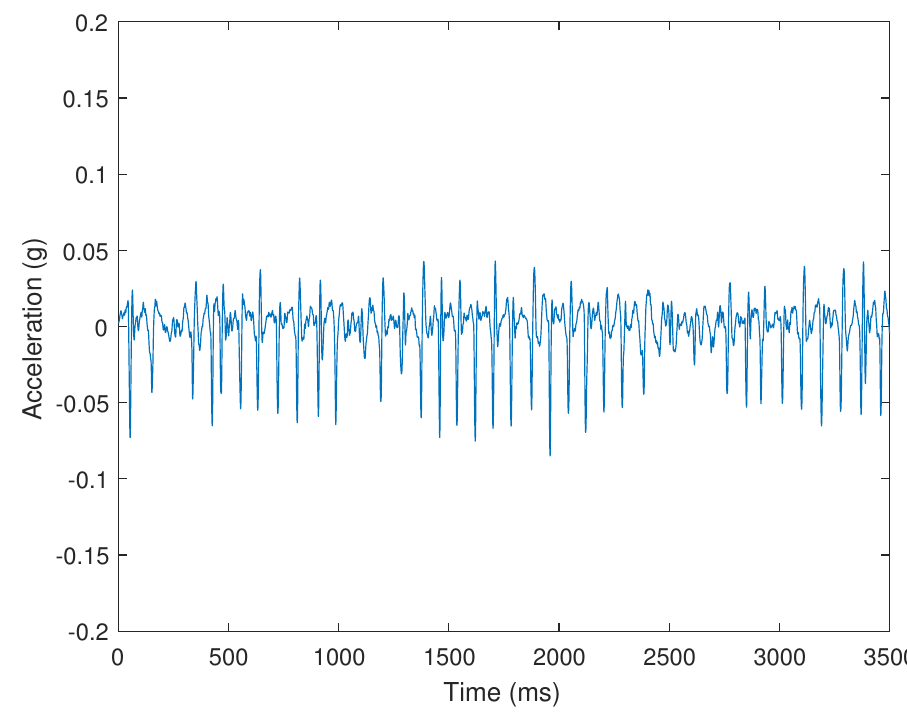
Figure 3. Right side acceleration of the healthy test